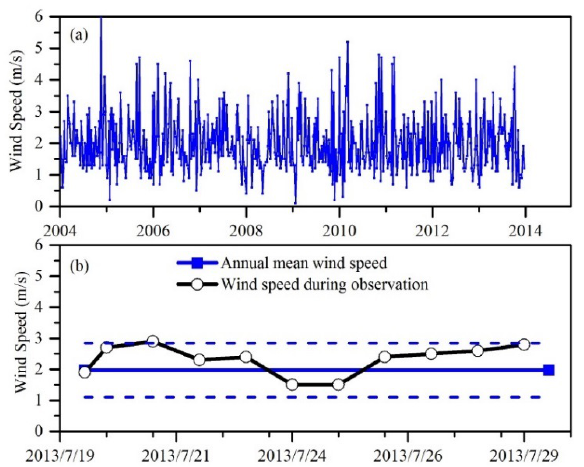
Figure 6. Wind speed at Poyang Lake: ( a ) daily time series results from the meteorological site, ( b ) comparison between annual mean wind speed and wind speed during field measurements.